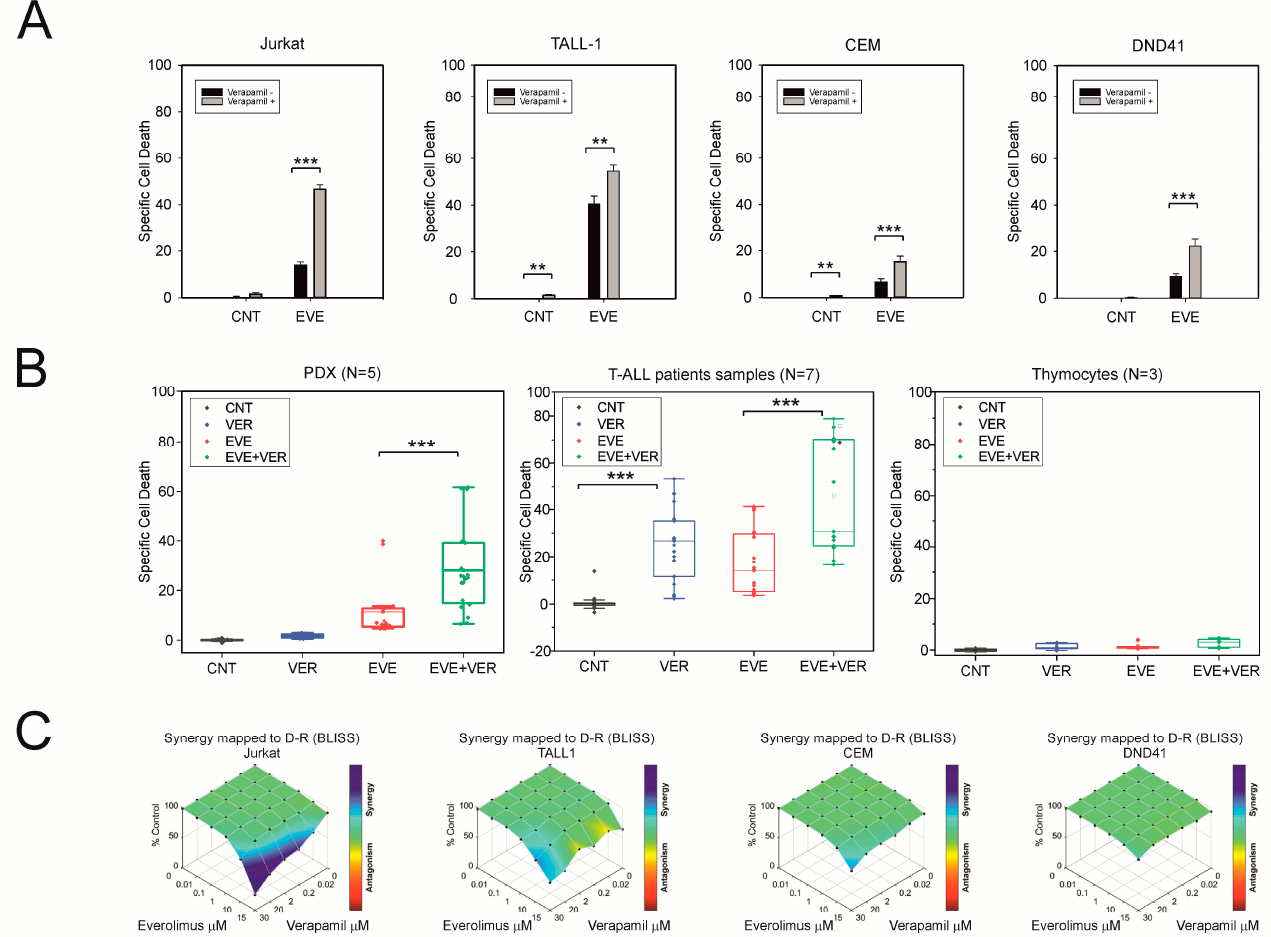
Figure 2. Verapamil enhances cell death induced by everolimus. ( A ) Plots of specific cell death assessed by PI staining in T - ALL cell lines treated for 24 h with verapamil (VER, 20 ng/mL), everolimus (EVE, 10 μ M), or with both drugs. ( B ) Plots of specific cell death induced by a 24-hour treatment with VER (20 ng/mL), EVE (10 μ M), or both drugs in five T - ALL PDX, primary tumor cells from T - ALL patients ( N = 7), and three preparations of normal thymocytes; mean values and standard error bars are shown. The indicated pairwise comparisons were statistically significant with the Mann-Whitney test; *** indicate p values < 0.001, ** <0.01. ( C ) Combinatory effects of EVE and VER on T - ALL cells. Shown are Combenefit-generated surface maps for drug combinations in T - ALL cell lines. The axes indicate concentrations of each drug.